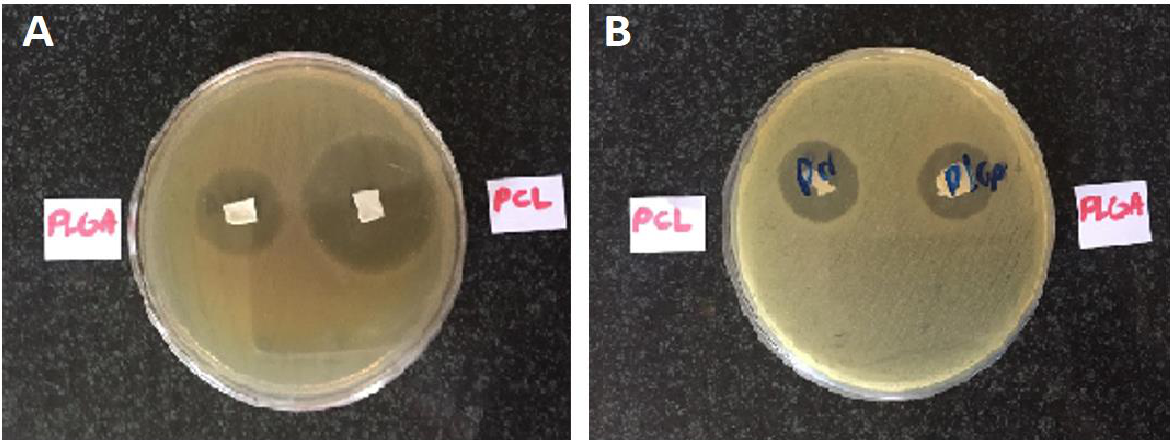
Figure 3. The inhibition growth zones and antimicrobial efficacy of the prepared nanofibers against S. aureus ( A ) and E. coli ( B ).